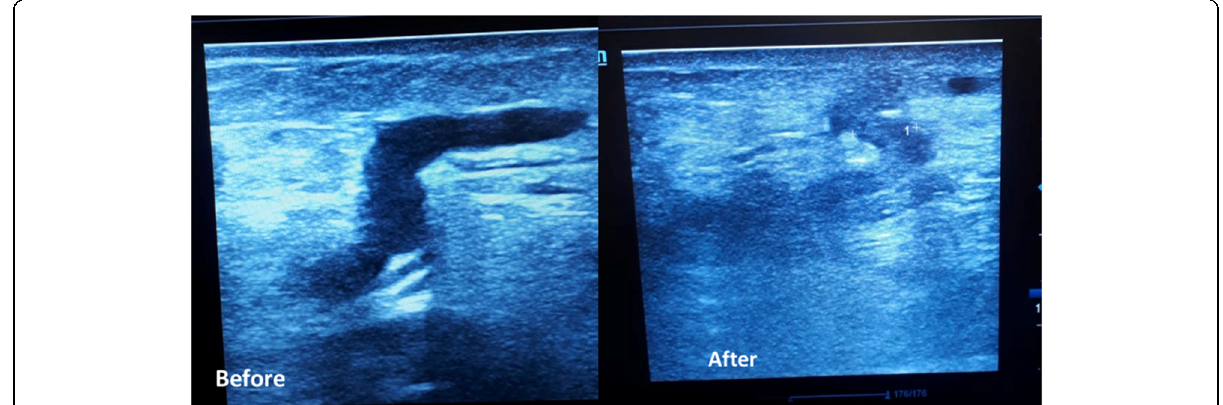
Fig 8 Refluxing perforator before USGFS and after showing complete occlusion of the